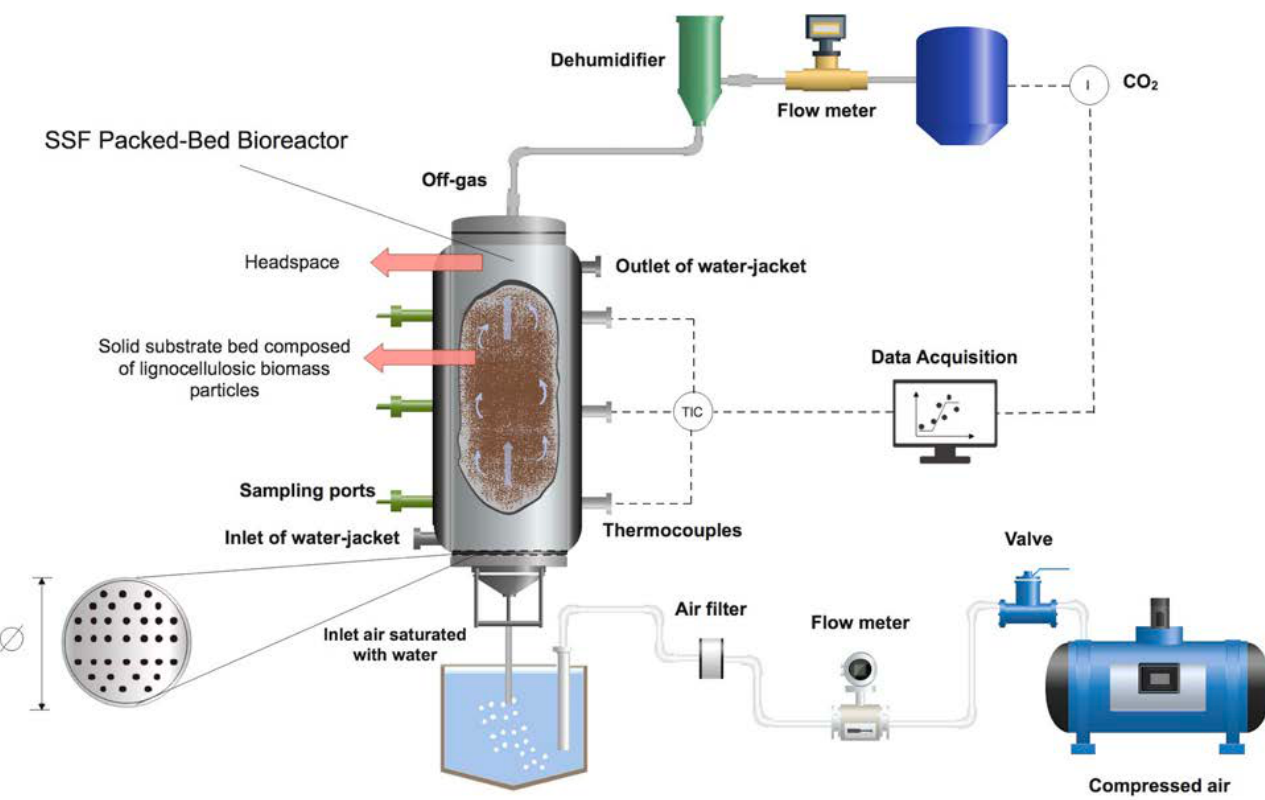
Figure 2. Schematic representation of a typical SSF packed-bed bioreactor for lignocellulosic biomass conversion.